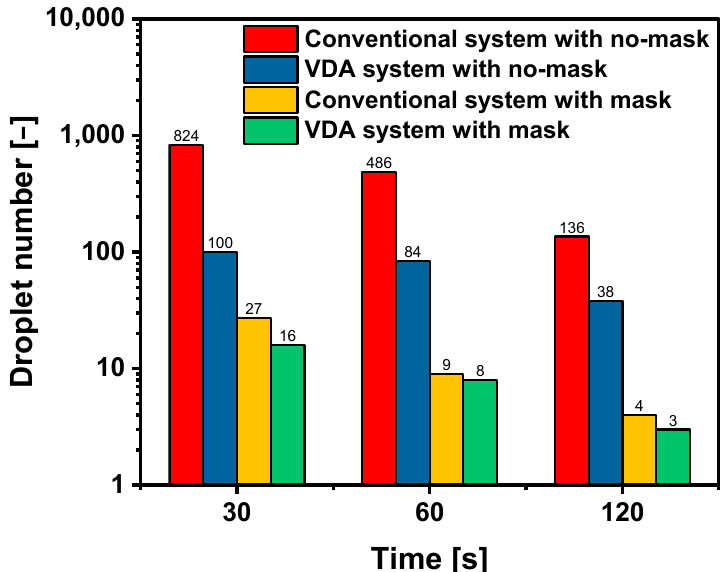
Figure 15. Variation in the droplet number in the conventional and VDA systems with and without the mask.